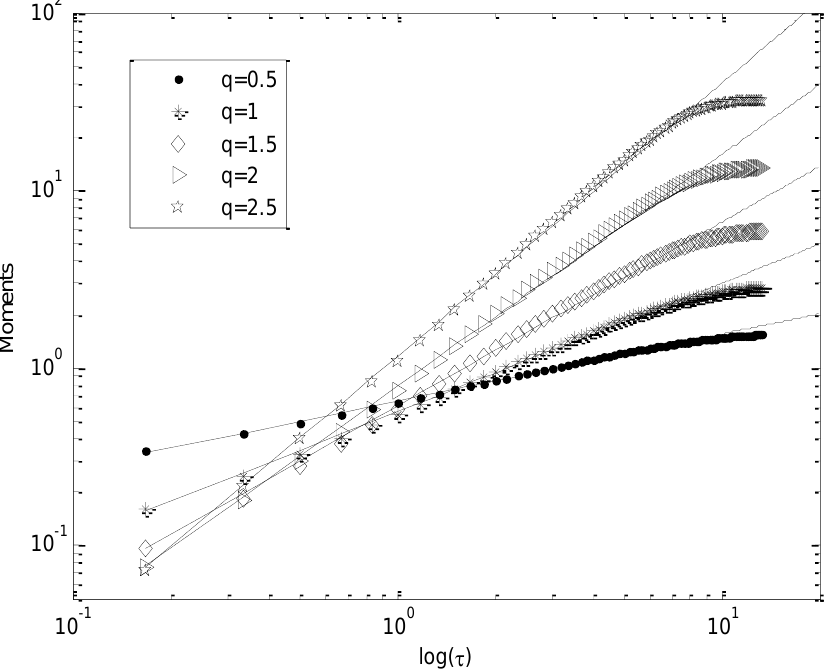
Figure 5. Scaling of the structure functions in log-log plot for moments of order 0.5, 1, 1.5, 2, and 2.5 for time series B.